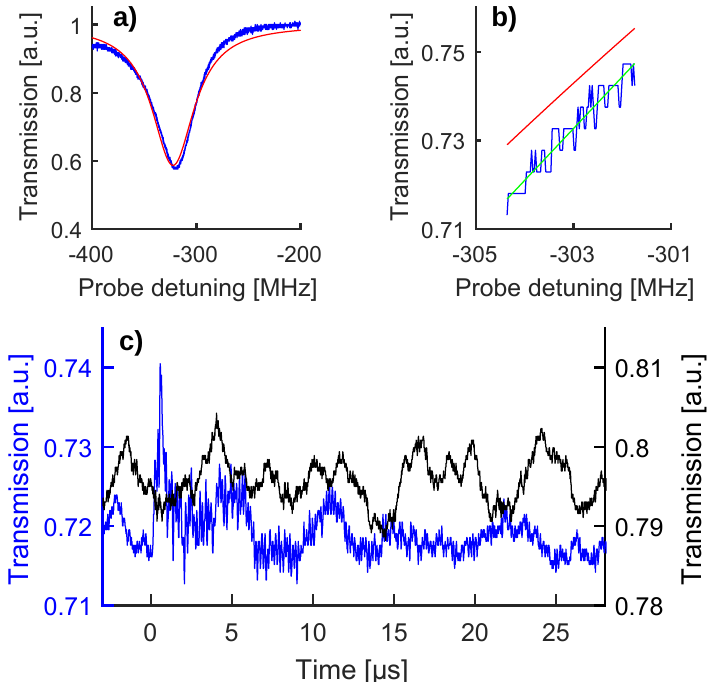
Figure 2. ( a ) WGM resonance used for this experiment (blue curve) along with an overall fit (red curve, theoretical shape according to [41]). ( b ) Enlargement of the half-maximum work-point, showing that the parabolic fit (green curve) allows a more faithful representation of the WGM fringe (blue curve) with respect to the overall fit (red curve). ( c ) The black curve is a baseline trace (or zero-signal trace) recorded after setting the probe laser on the half-maximum work-point and while keeping the pump laser disabled. The blue curve is a raw read-out of the photoacustic (PA) wave generated by shining the gold nanorods (GNR) with a single pump pulse, producing a 10 mJ/cm 2 fluence. This panel uses two ordinate axes to keep the aforementioned color